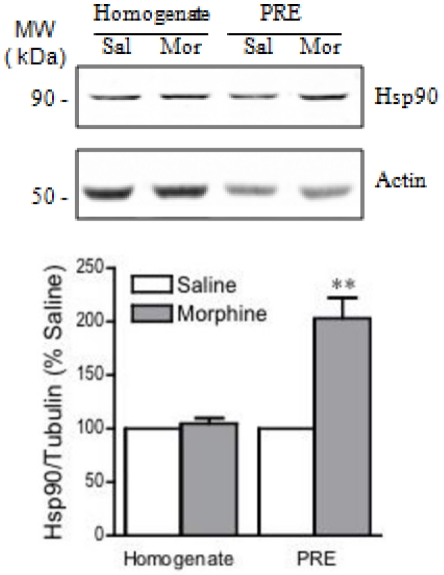
Hsp90 levels after chronic morphine administration.Western blot analysis showed an increase in the levels of Hsp90 in the PRE fraction after chronic morphine administration. No changes were observed in total homogenates suggesting redistribution of the protein rather than increases in gene expression changes. Protein levels were normalized to actin. **p<0.01 compared to saline treated (n = 6). A representative blot of 6 is shown.